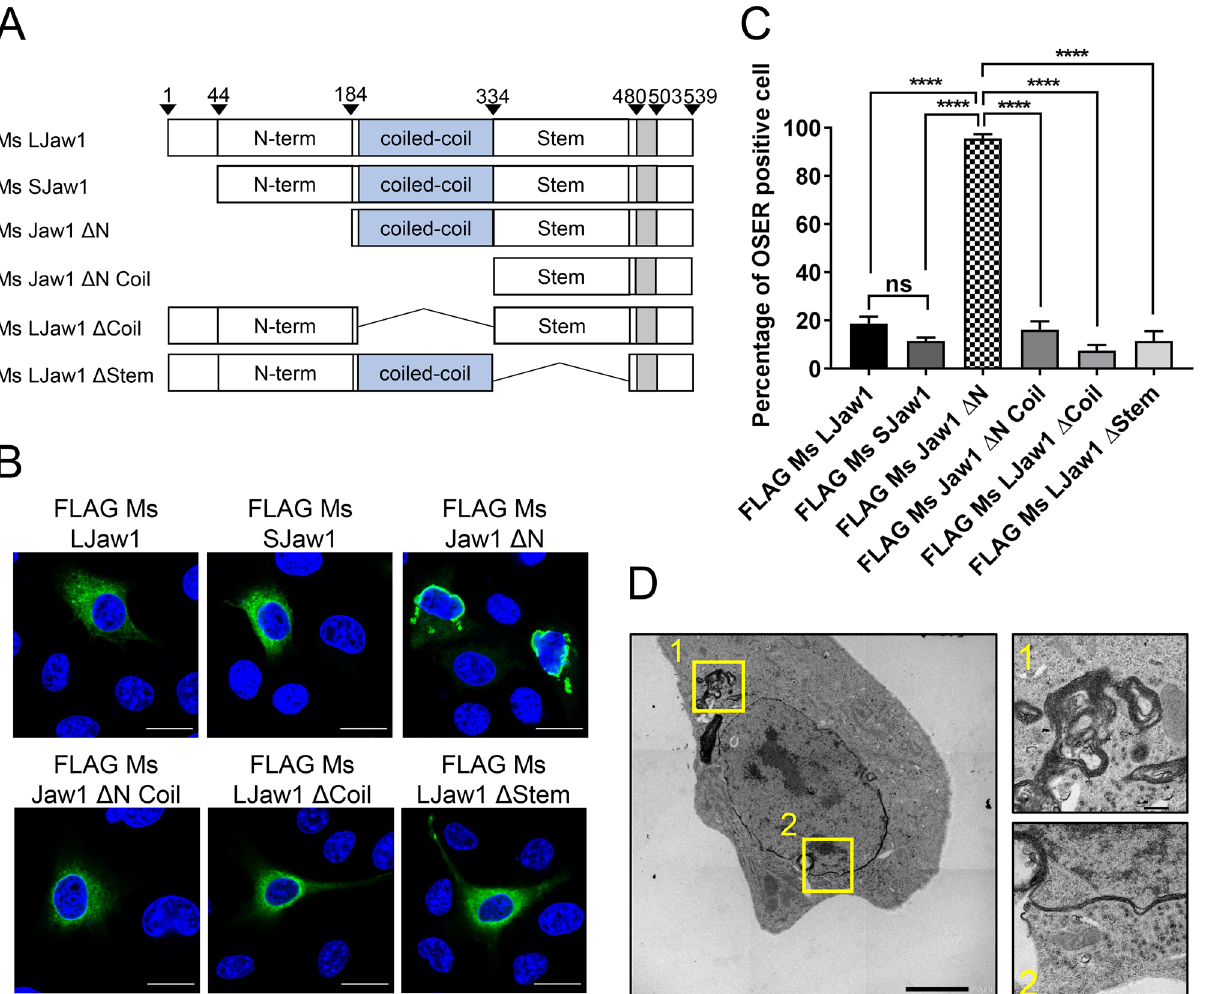
Figure 2. Observation of the OSER by the expression of Jaw1 ΔN. ( A ) Schematic representation of Mouse Jaw1 (LJaw1; long form Jaw1, SJaw1; short form Jaw1) and mutants lacking the N-terminal region (Ms Jaw1 ΔN), N-terminal region and coiled-coil domain (Ms Jaw1 ΔN Coil), coiled-coil domain (Ms LJaw1 ΔCoil) and stem region (Ms LJaw1 ΔStem). ( B ) FLAG Ms LJaw1, FLAG Ms SJaw1 or deletion mutants were expressed in B16F10 cells by transfection. After incubation for 24 h, immunostaining was performed using an anti-FLAG rabbit antibody (green). Nuclei were stained with Hoechst33342 (blue). The images were acquired by confocal microscopy. Scale bar; 20 μm. ( C ) Counting of the cells having OSER structures out of the FLAG positive cells in ( B ) (n = 100). In the graph, the percentage of cells with OSER structures is shown based on the average of four independent experiments per condition. Error bars show the S. D. “ns”, not significant; **** P < 0.0001, Turkey Kramer’s t -test. ( D ) Electron micrographs of the B16F10 cells expressing FLAG Ms Jaw1 ΔN. The magnified images are shown in the boxes at right (box 1; whorls and cisternae stacks, box 2; nuclear karmellae). Scale bar; left box; 5.0 μm, right boxes; 500 nm. The OSER positive cells were classified as the ones with a highly dense membranous structure (N =